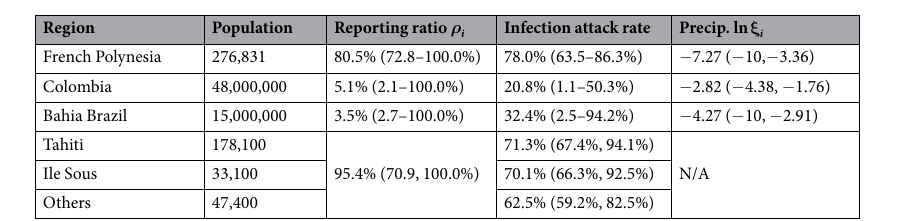
Table 1. Parameter estimates for French Polynesia, Colombia, and the State of Bahia in Brazil. The 95% confidence intervals are given in the